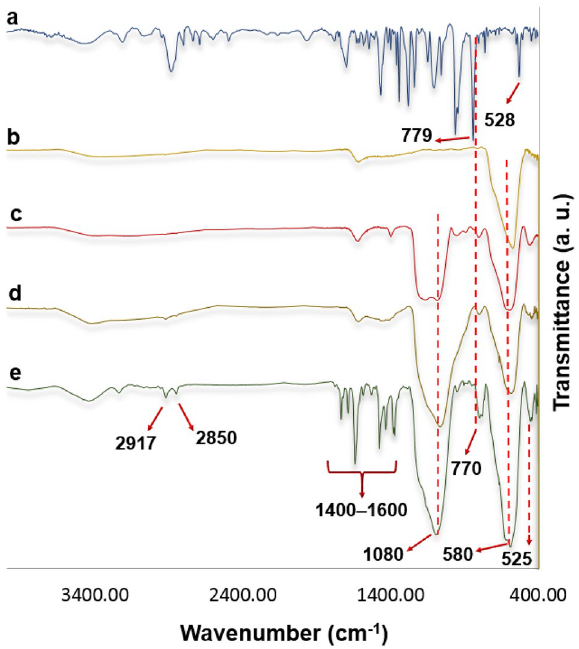
Figure 2. FTIR spectra of: ( a ) 2-mPEG-4-(Pd(dpa)Cl 2 )-6-chloro-1,3,5-triazine, ( b ) MNPs, ( c ), MNPs@SiO 2 ( d ) MNPs@SiO